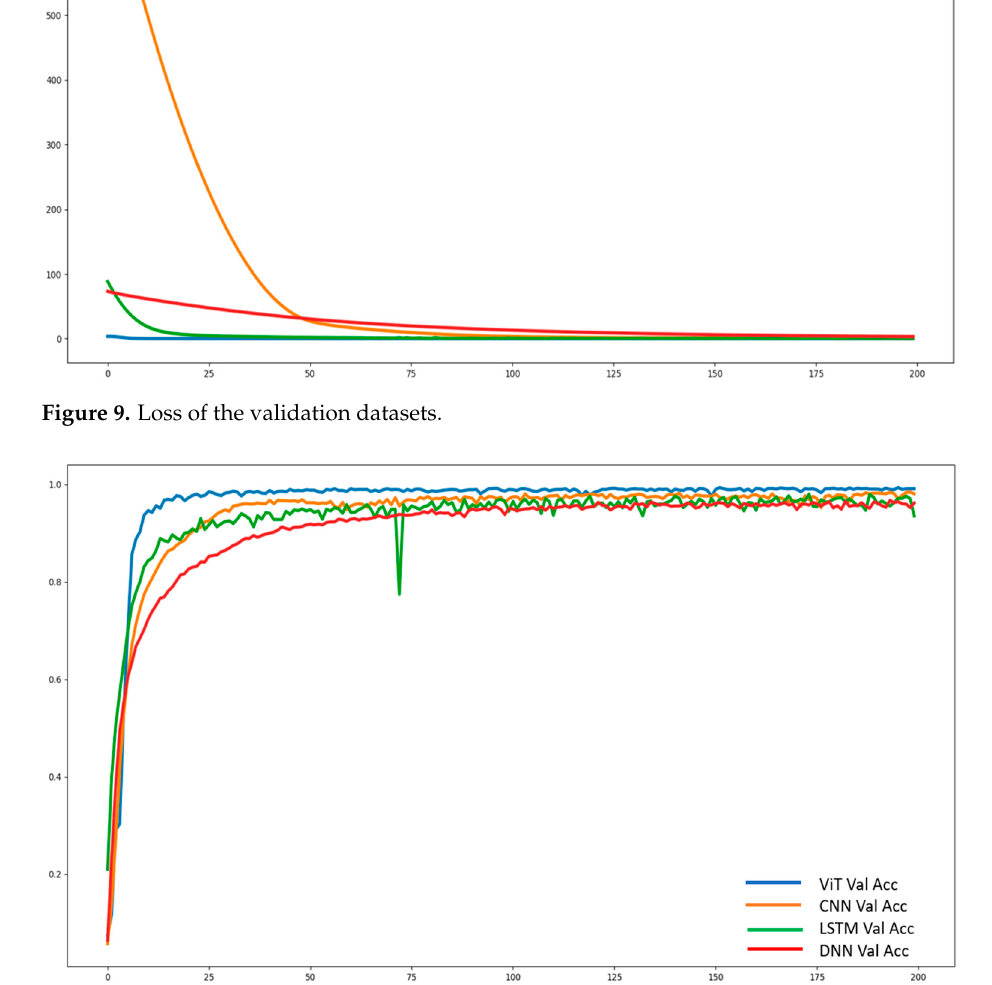
Figure 10. Accuracy graphs of the validation datasets. Table 3. Validation accuracy results of the neural network models.